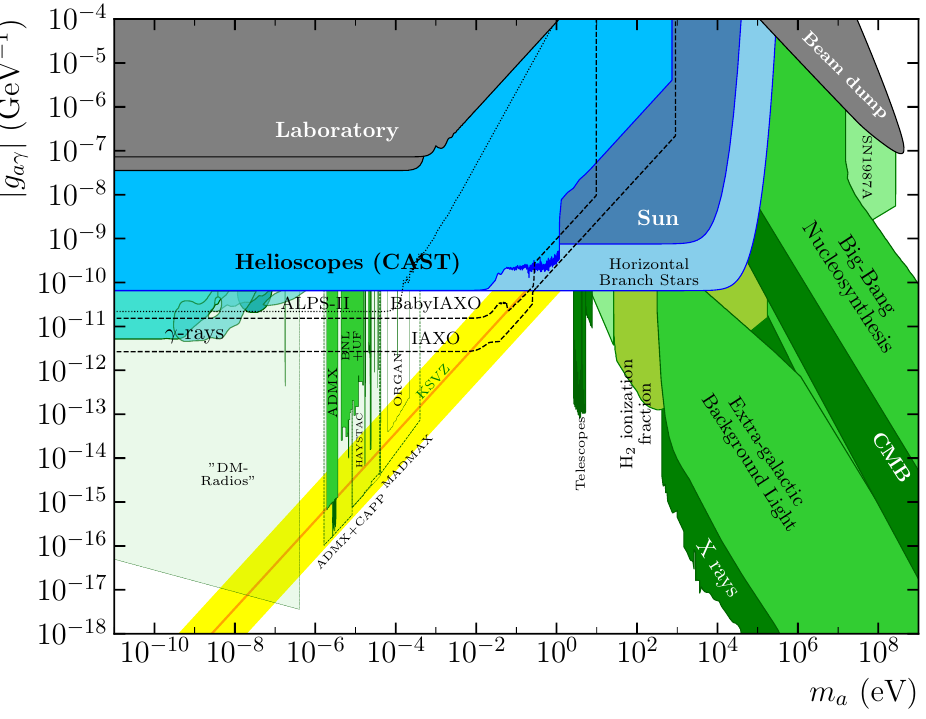
Figure 1: Overall panorama of current bounds (solid areas) and future prospects (semi-transparent areas or dashed lines) in the g text (mostly in sections 6 to 8) and reference [ 2 ] for details on the different